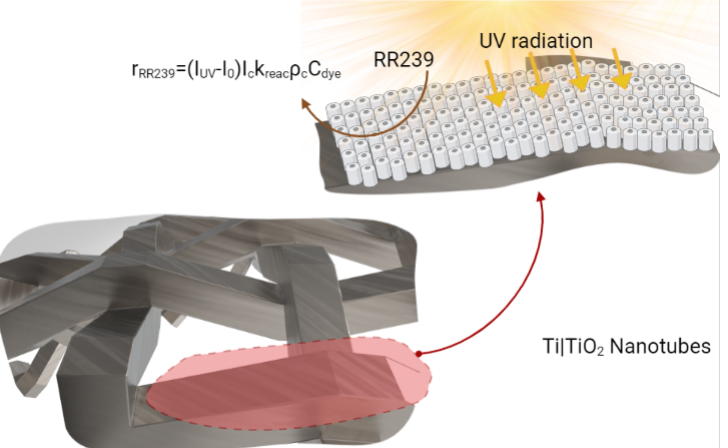
Figure 14. Superficial degradation reaction on titanium dioxide nanotubes.